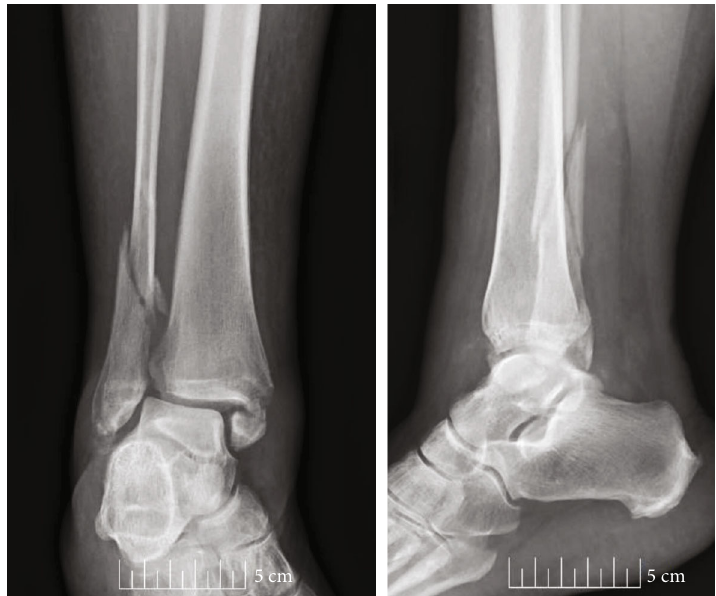
Figure 1: Initial radiographs demonstrating trimalleolar ankle fracture.